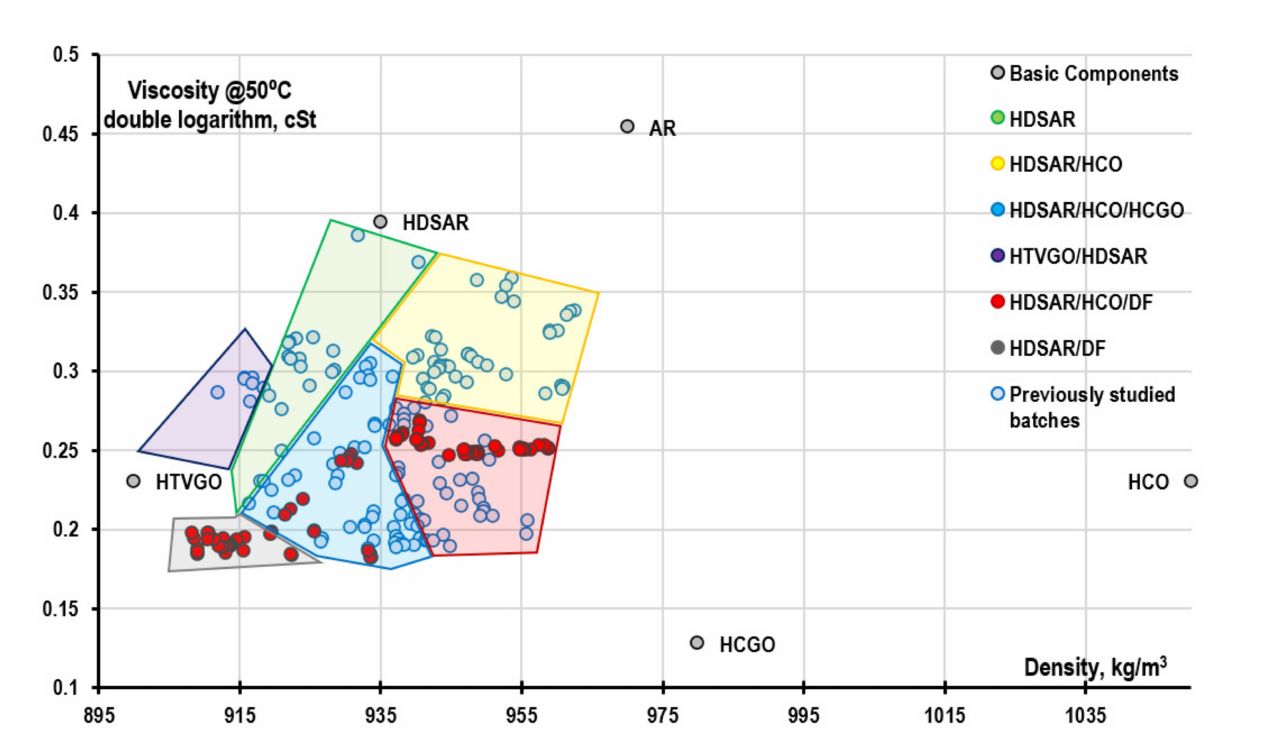
Figure 13. BP batches in logarithmic coordinates [63].